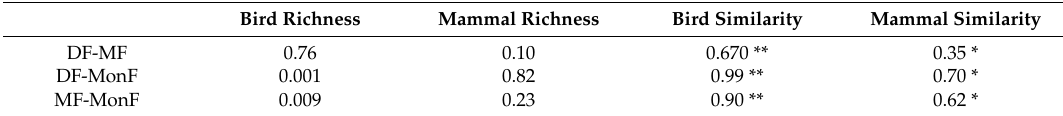
Table 2. p values of Tukey test (left) and R 2 values of ANOSIM (right) for birds and mammals between forest treatments (DF = dry forests; MF = moist forests; MonF = montane forests). In the ANOSIM, asterisks represent significance at the 0.05 (*) and 0.01 (**) levels, respectively. Bird Richness Mammal Richness Bird Similarity Mammal Similarity DF-MF 0.76 0.10 0.670 ** 0.35 * DF-MonF 0.82 0.99 ** 0.90 ** 0.62 *